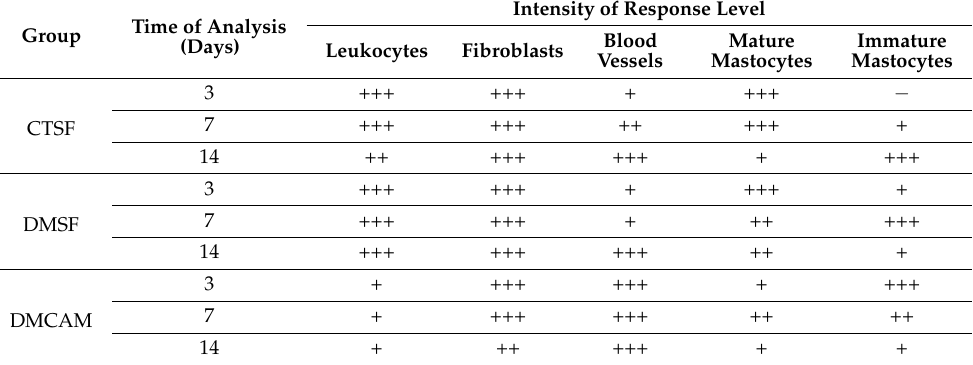
Table 2. Histomorphological evaluation performed on days 3, 7 and 14, in which the occurrence intensity of leukocytes, fibroblasts, blood vessels, mature and immature mastocytes was analyzed. The following scoring system was used in the evaluation: − for absent; + for light; ++ for moderate; and +++ for iIntense responses. The assessment consisted of a slide scan and comparisons of the